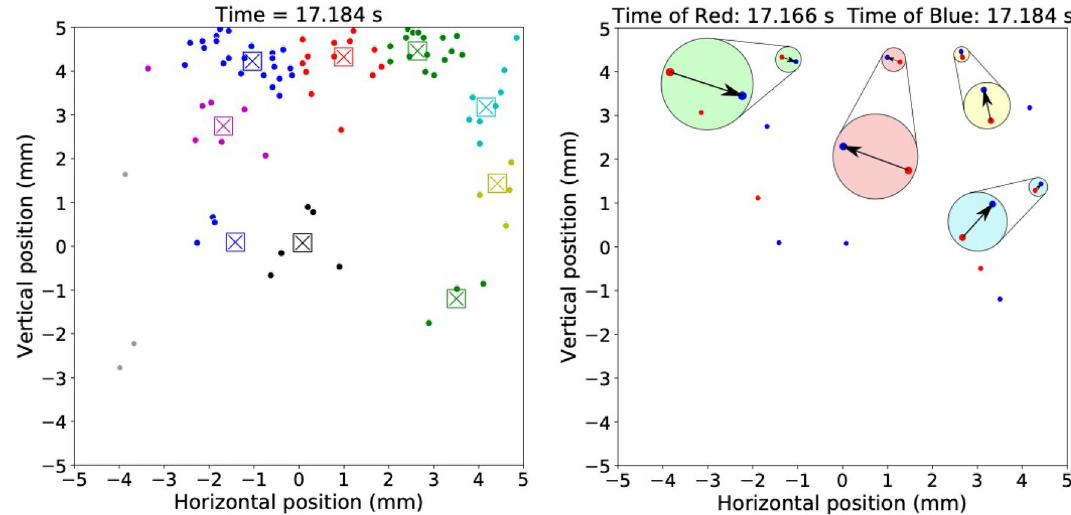
Figure 4. (left) Excimer fluorescence having intensity > 4 σ above background (small dots) color-coded according to cluster identity obtained using the MeanShift clustering algorithm (bottom heater power = 7.32 mW). The center of a large symbol represents the cluster centroid. (right) Positions of centroids for times of 17.184 (shown as the large symbols for this time on the left) and 17.166 s corresponding to blue and red dots, respectively. Specifically, the blue symbols in this figure (right) correspond to the positions of cluster centroids in this figure (left). In this figure (right), four pairs of red and blue centroids were identified by the correlator metric discussed in the text as being the same clusters that moved from time = 17.166 to time = 17.184 s (arrows). The arrows are the four displacement vectors calculated for the four cluster centroid pairs. The figure also shows pairs of displacement vectors magnified five